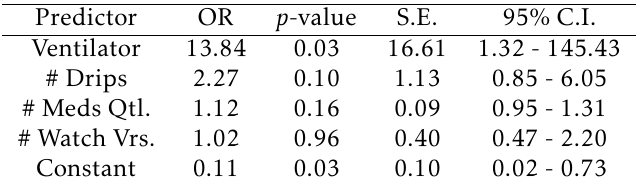
Table 3. Ordered logistic regression results show the ability to predict if a patient is acute (OR = Odds Ratio, S.E.